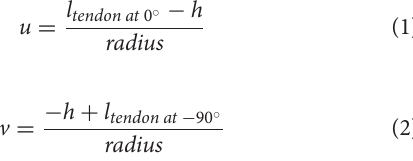
The continuum joint has two sets of sensors that run the length of the joint and start at the base at 0 and − 90 ◦ on the circumference of the joint as shown in Figure 3 . These locations allow each set of sensors to independently measure the two degrees of freedom ( u and v ) as the mounting points correspond to the directions of the bending axis. Thus, bending about each axis will only be measured by a single set of